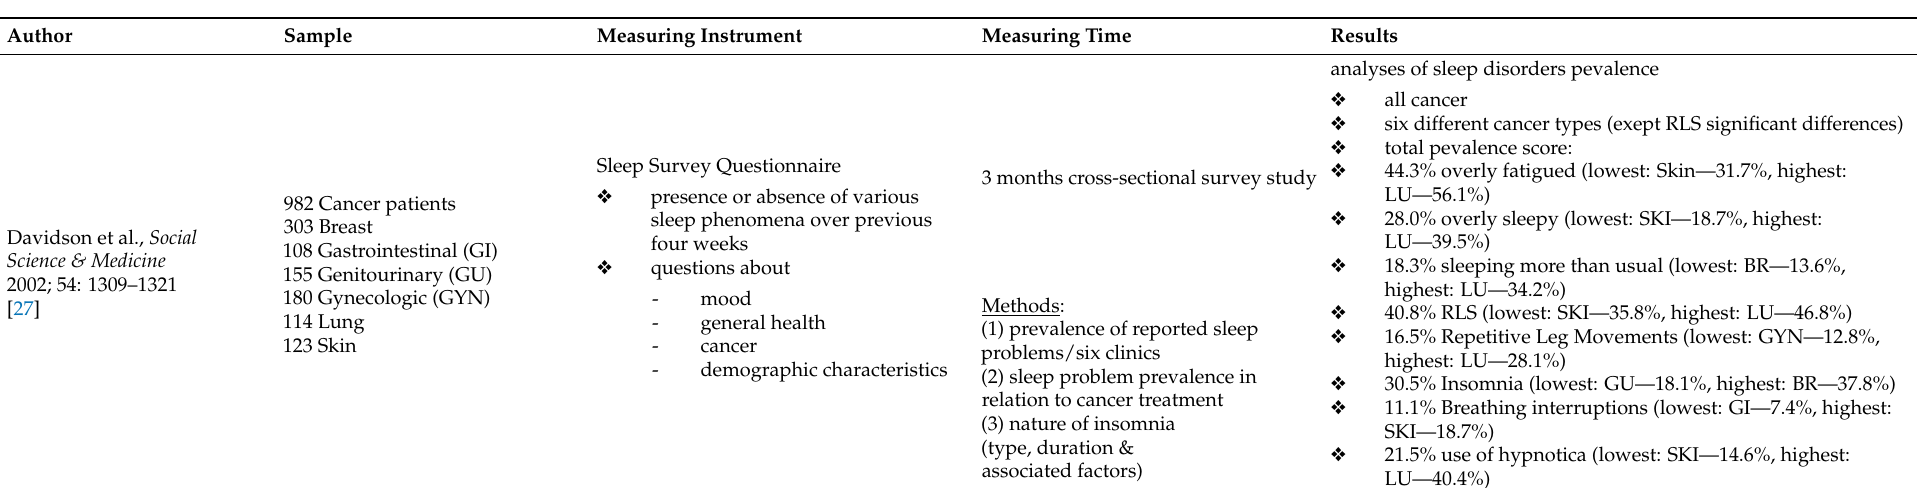
Table 3. Study on Sleep Disorders in